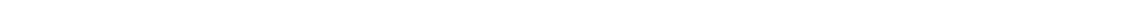
Fig. 1 Pharmacogenetic inactivation of HIPP cells increases background context conditioning. a Schematic of the context conditioning